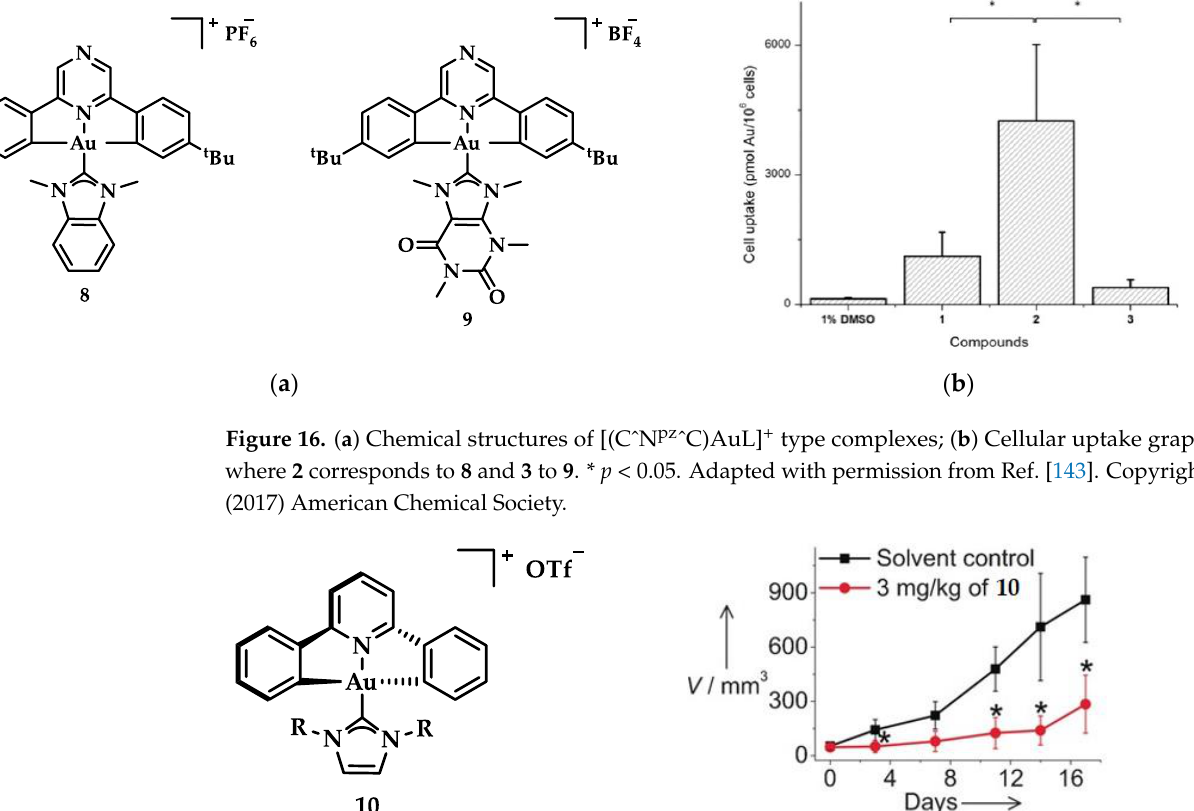
( b ) Figure 18. ( a ) Acridine-functionalized [(C^N pz ^C)Au III (NHC)] + complex; ( b ) Cellular uptake in MCF-7 cells (compounds 11 ). ** p < 0.005. Adapted with permission from Ref. [144] . Copyright (2018) The Royal Society of Chemistry. Neutral auxiliary NHC ligands were employed in synthesis of Au(III) complexes by Che et al. displaying a potential anticancer activity in vitro and in vivo. Complexes with the general type of [Au n (R – C^N^C) n (NHC)] + (Figure 19) were studied for their interaction with DNA and a known intercalating compound, ethidium bromide (EB) [145]. The re- sults indicated that the mode of binding is intercalation based on the binding constant K b that demonstrates the magnitude of interaction with ctDNA (K b = 5.4 × 10 5 M −1 ) [146]. Complex 12 seems to hamper topoisomerase I (TopoI) mediated DNA relaxation. Further in vivo studies were also conducted on a nude mice model; in a 28-day period, a dosing